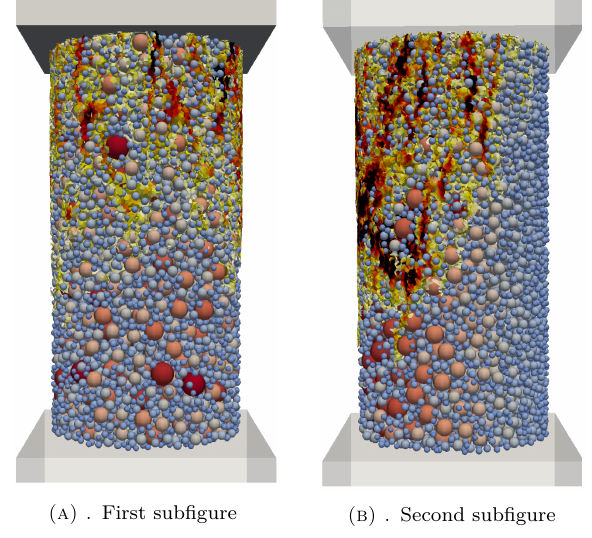
Figure 3. Results of the different particle distribution on the fracture propagation.